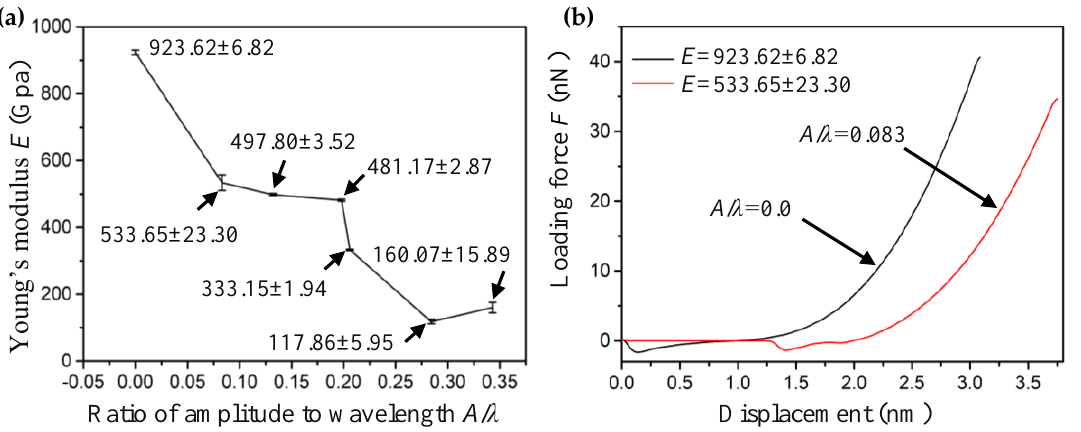
Figure 7. ( a ) The Young’s modulus ( E ) of wrinkled graphene versus the ratio of A / λ . ( b ) The loading force–displacement curves of graphene ( A / λ = 0 and A / λ = 0.083).